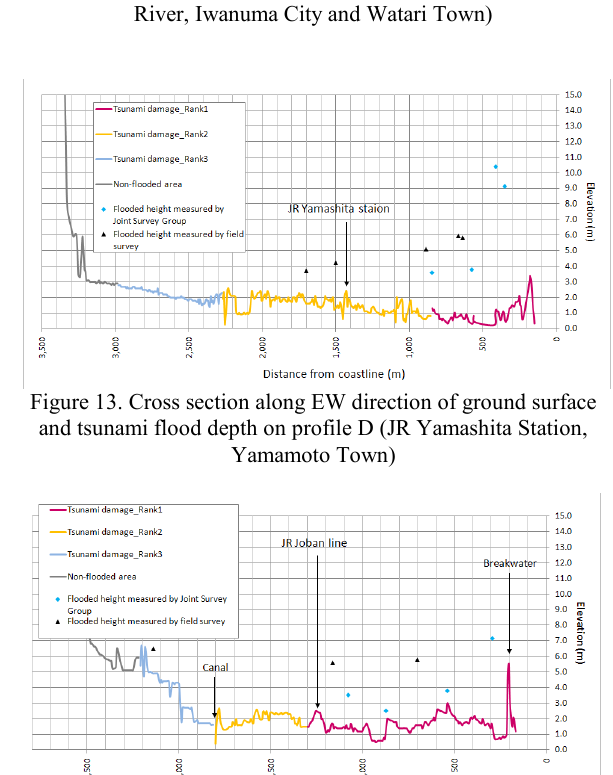
Figure 12. Cross section along EW direction of ground surface and tsunami flood depth on profile C (Mouth of Abukuma